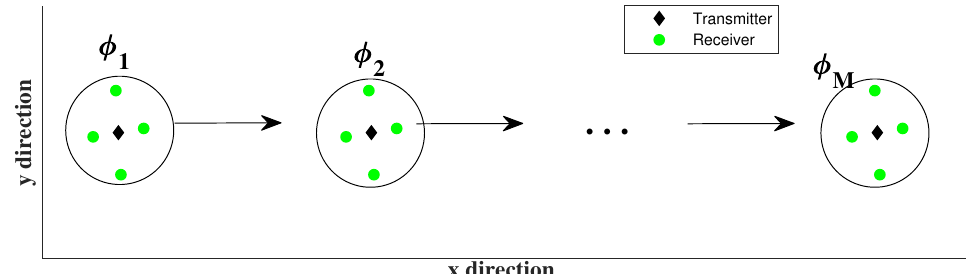
Figure 2. Scenario showing where both the transmitter and receivers are moving together.